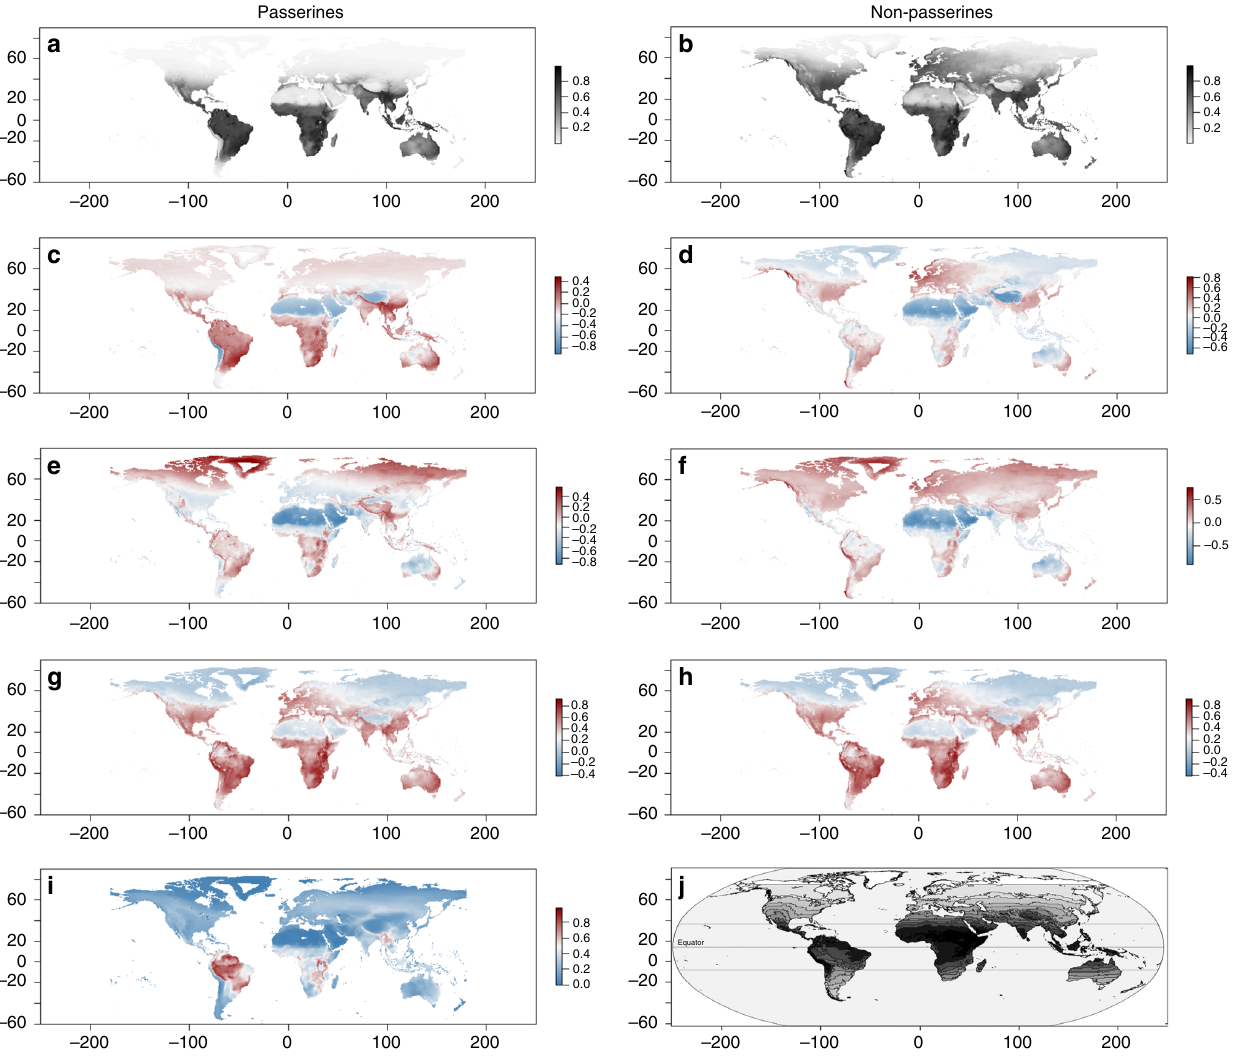
Fig. 4 Probability of black skin occurrence estimated by MAXENT 56 using solar radiation (kJm-2day-1), average precipitation (mm), and average maximum temperature (°C) as predictor values in passerines (A) and non-passerines (B). Additional panes re fl ect the difference of the predicted black skin probabilities in relation to UV radiation in passerines ( c ) and non-passerines ( d ); The difference of predicted probabilities and relative maximum temperature (maximum temperature/maximal maximum temperature value) in passerines ( e ) and non-passerines ( f ); The difference of predicted probabilities and relative precipitation (precipitation/maximal precipitation value) in passerines ( g ) and non-passerines ( h ); The relative bird biodiversity (bird biodiversity/maximal bird biodiversity) ( i ) and the distribution of black skin colour in humans ( j ) (Adapted from Chaplin 40 ). The darkness gradients in a , b and j indicate the probability of black skin being present: high probability regions are dark, low probability regions are white. In b – d values near 0 (white) indicate a good fi t between predictor value and black skin probability while non-zero values indicate increasing tendencies to a mismatch between predictor and predictor indicating that another variable contributes more to the black skin prediction model. All climatic variables were yearly averaged over a span of 30 (2) on the back of the head, near the neck region. To do so we lifted, or moved away, feathers and registered whether the skin was black, yellow or red. Addi-